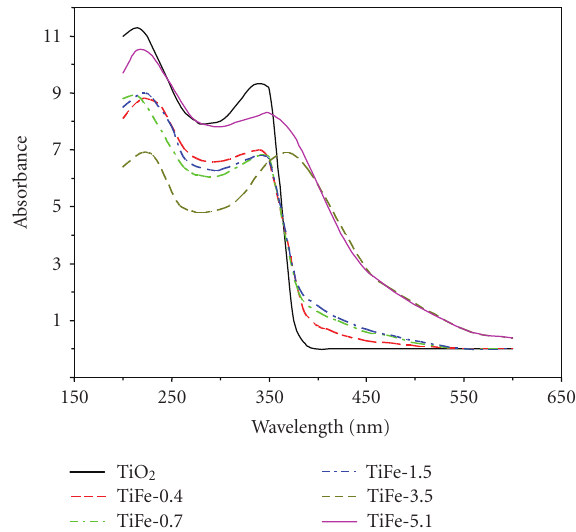
Figure 9: UV-Vis spectra of Fe-doped TiO 2 with di ff erent iron con- tent.